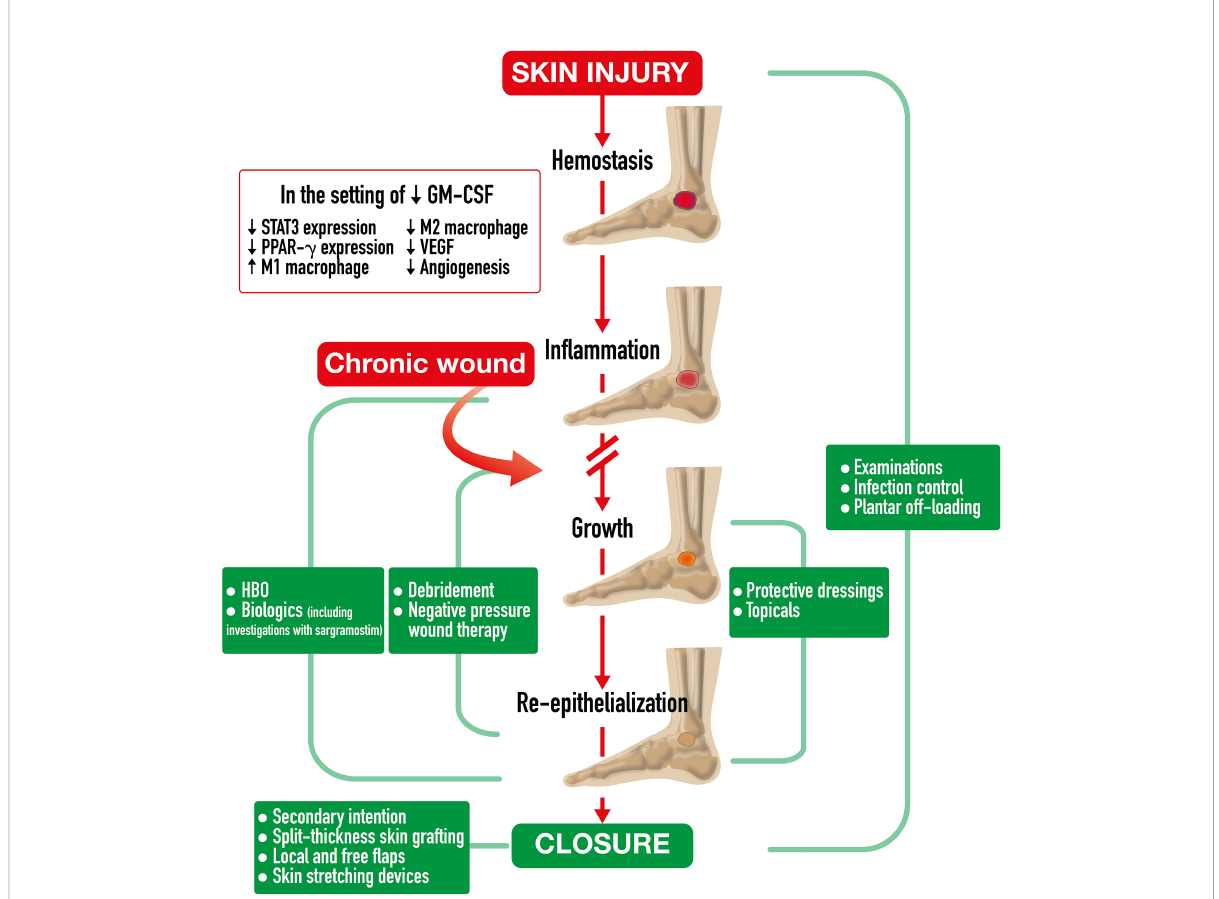
FIGURE 2 Chronic Wound Healing Process and Treatment Strategies. Chronic Wound Healing Process and Treatment Strategies. After spontaneous skin injury, the chronic wound healing process is comprised of four phases including hemostasis, in fl ammation, growth, and re-epithelization. This process often stalls at the in fl ammation stage in which GMCSF de fi ciency leads to reduced neutrophil and macrophage chemotaxis and in fi ltration, reduced signal transducer and activator of transcription 3 (STAT3) expression, insuf fi cient macrophage differentiation, decreased efferocytotic function, impaired PPAR-g expression, and diminished pro-in fl ammatory M1 to pro-healing M2 transition. Insuf fi cient macrophage actions impede granulation tissue formation, vascular endothelial growth factor (VEGF)-dependent angiogenesis, and contractile myo fi broblast differentiation. All these factors ultimately delay wound closure. A continuum of treatment strategies for chronic lower extremity wounds is required for wound healing. Diverse strategies overlap to address key healing mechanisms. Strategies include wound bed preparation by debridement and negative pressure therapy, experimental immunologic modi fi cations, and granulation tissue promotion with biologics such as sargramostim [recombinant human granulocytemacrophage colony-stimulating factor]), hyperbaric oxygen therapy (HBO), topicals, and protective dressings, as well as wound closure, including secondary intention, split thickness skin grafting, local and free fl aps, and skin stretching devices. Examinations, antibiotic therapy, and plantar off-loading may be required at any